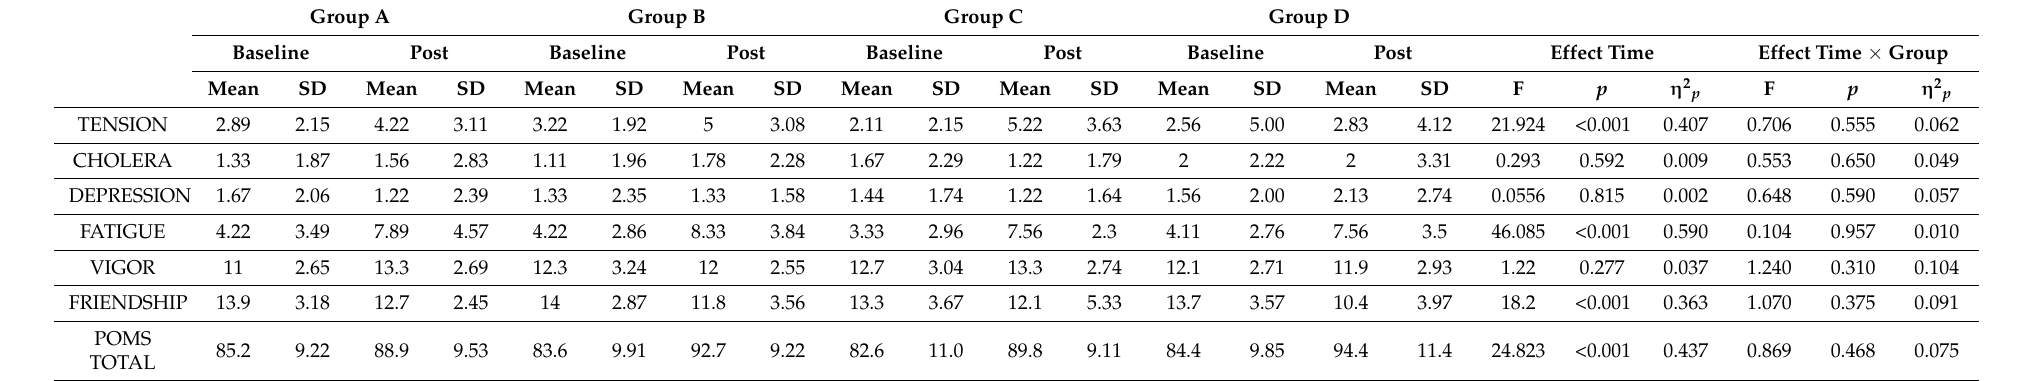
Table 1. Score of POMS scale before and after intervention.